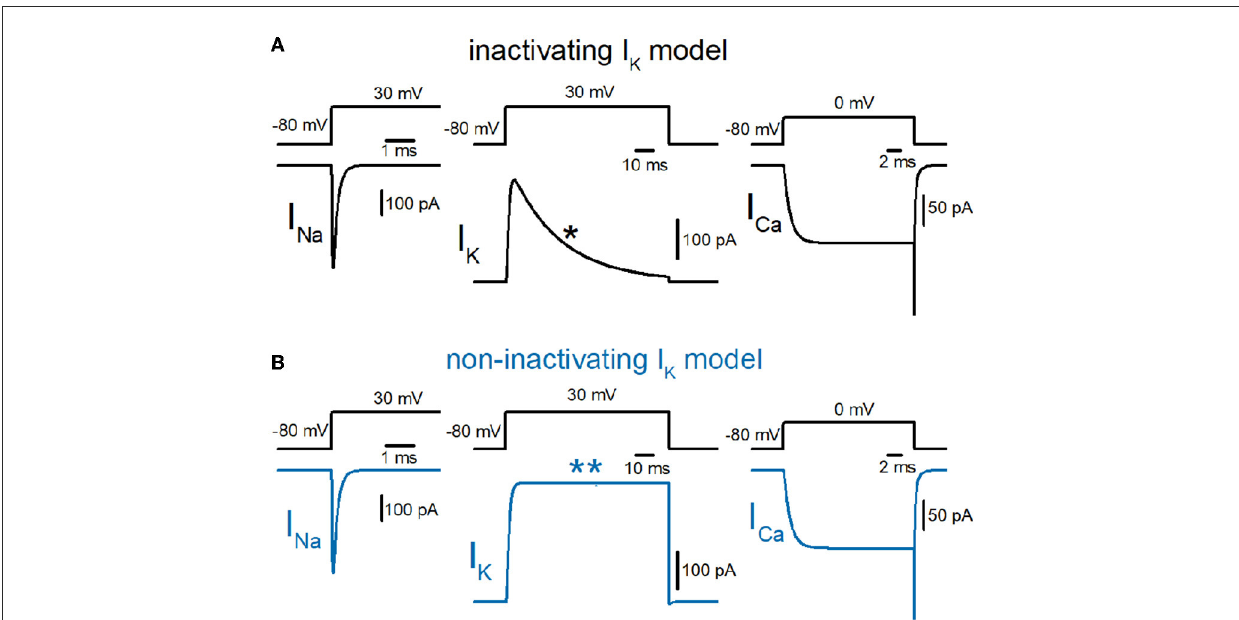
FIGURE1 Reconstruction of axonal sodium, potassium, and presynaptic calcium current on the hippocampal mossy fibers. (A) Kinetic properties of sodium (I Na ), potassium (I K ), and calcium (I Ca ) current of the models reconstructed from the experimental data obtained from hippocampal mossy fiber boutons. Single-compartment models of 7 µ m diameter were used for these simulations. The I K currents with fast inactivation (as marked by the asterisk) were used for calculation (black traces). (B) Those of the models whose potassium channel property was replaced with the non-inactivating one (as marked by a double-asterisk, blue traces).